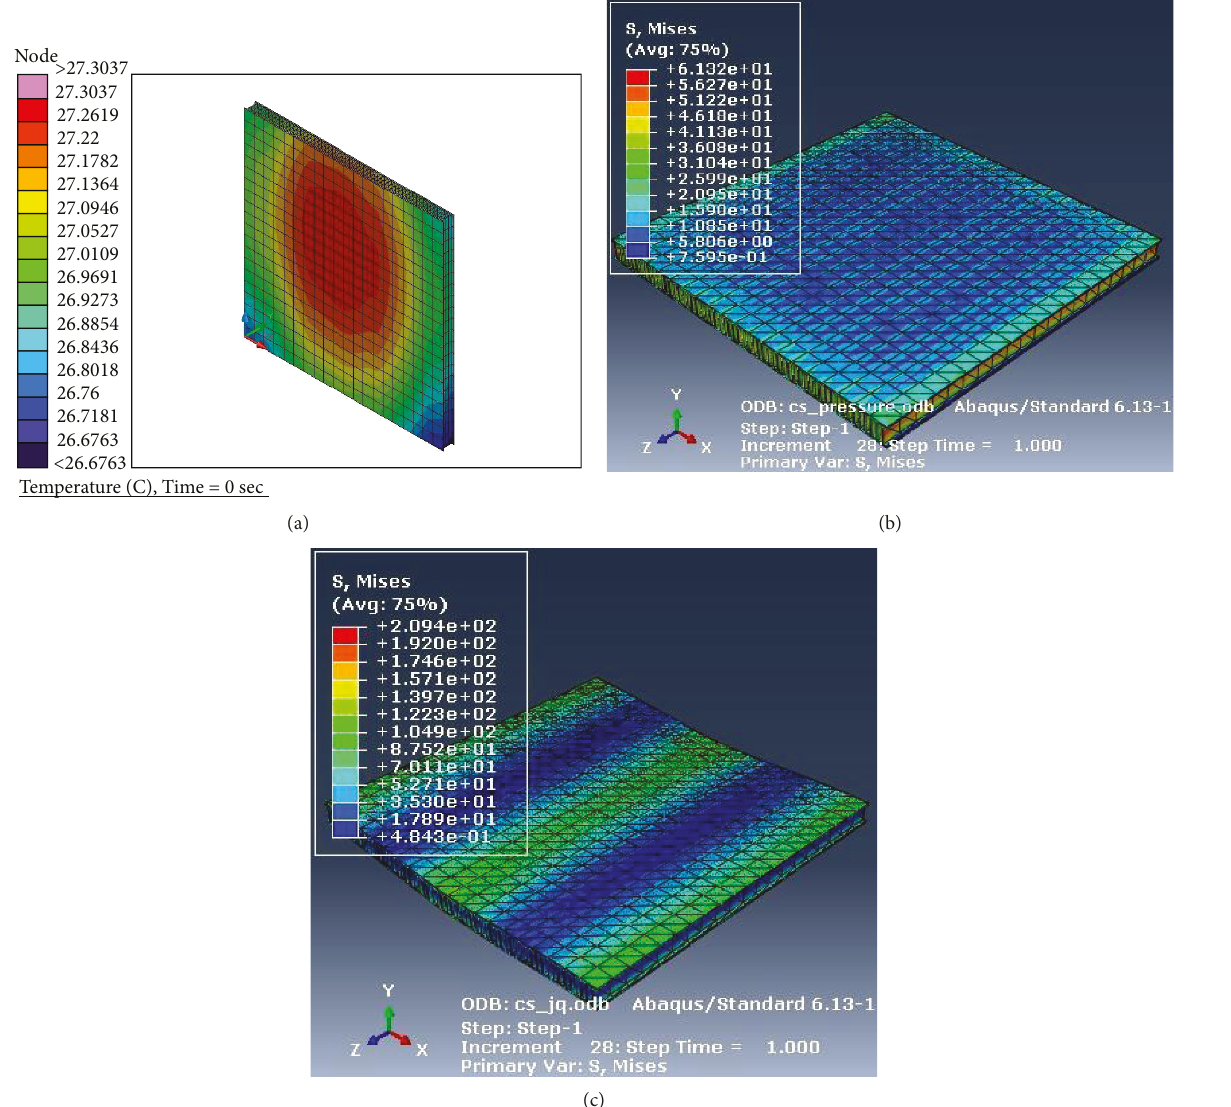
Figure 8: Performance analysis of the new type solar panel: (a) temperature di ff erence, (b) compression strength, and (c) shear strength. Table 5: Performance analysis results of the new type of solar panel. Temperature di ff erence ( °